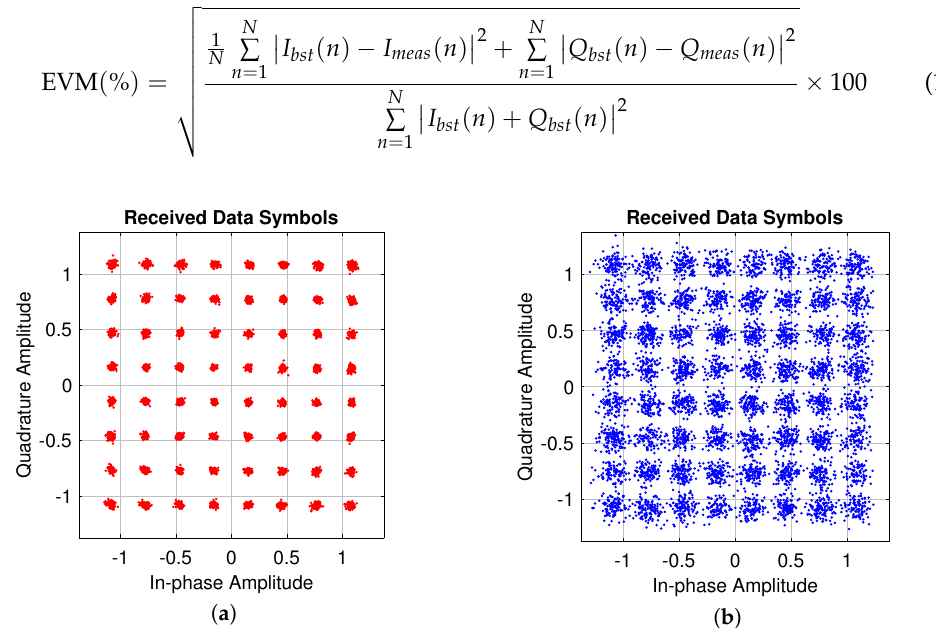
Figure 6. Constellations diagram for the actual transmitter LTE 10–MHz 64–QAM signal and CFR scale factor, ( a ) actual 64–QAM 10–MHz signal, and ( b ) receiver